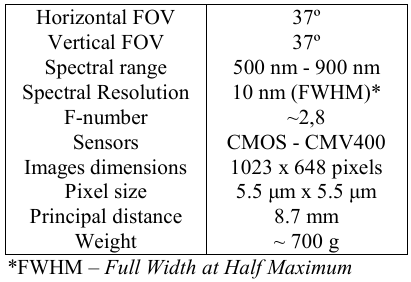
Table 1. Specifications of a Rikola camera, model 2014. Figure 1.a shows the 2014 model with external components: irradiance sensor and a GPS receiver of a Rikola camera. The rays bundle passes through the primary lens and other internal optical components, including the FPI and is redirected to two CMOS sensors by a beam splitting device (Fig. 1.b). Sensor 1 receives energy from near infrared (650–900 nm) and Sensor